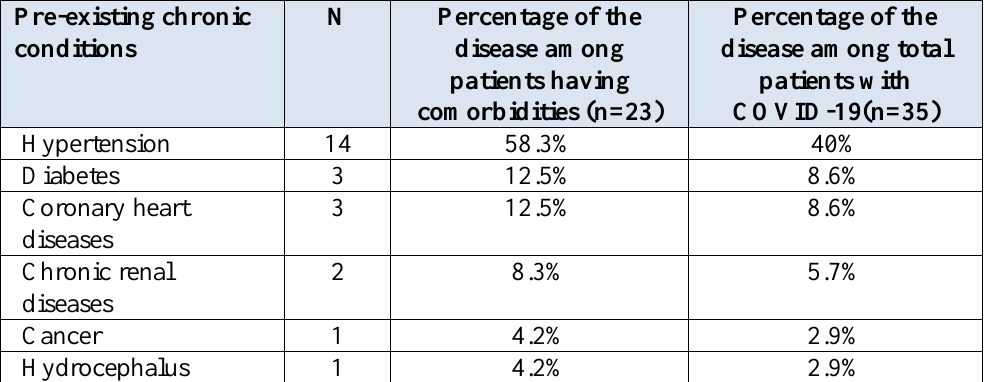
Table 2: Presence of comorbidity among patients with COVID-19 in Wasit province, Iraq